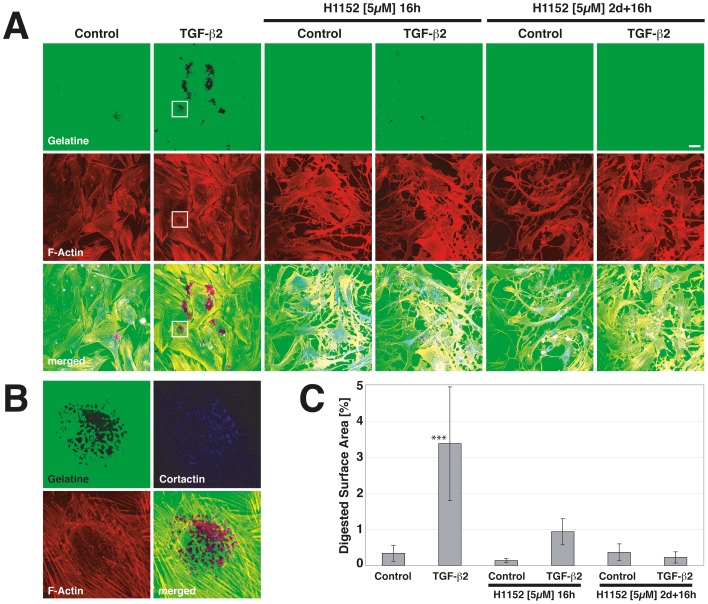
Effect of a ROCK inhibitor on TGF-β-induced invadosomes in HTM cells.(A) ECM degradation assay performed in the presence or absence of TGF-β2 or H1152 as indicated. (B) Close-up of the area marked in (A), depicting colocalization of cortactin and F-actin to sites of ECM degradation. (C) Quantitation of digested surface area in (A). Scale bar represents 40 µm (A), *** indicate p>0.001 in (C).